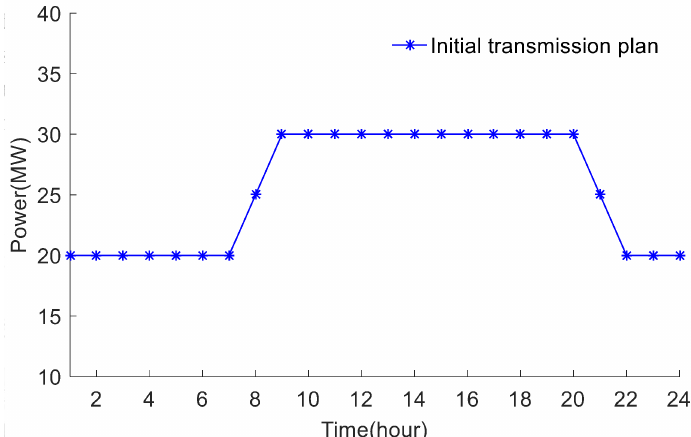
Figure 6. Initial transmission plan of DC tie line between interconnected